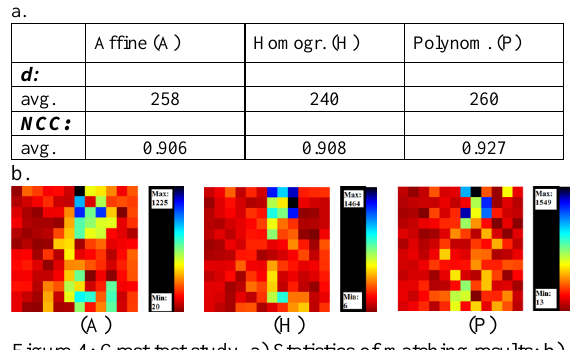
Figure 4: Crest test study. a) Statistics of matching results; b) Colour Map of the distances d for each shape